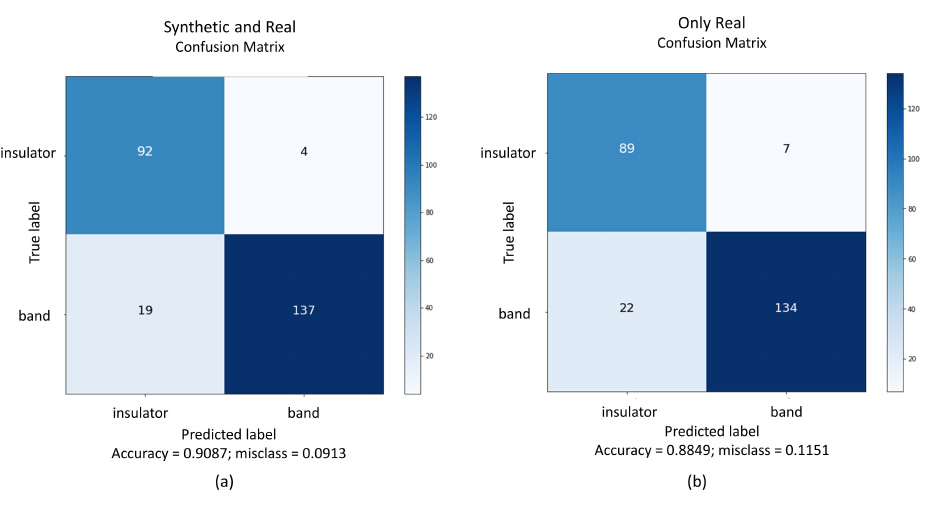
Figure 24. Confusion Matrixes of R-RGBD-1 tested on: ( a ) Resnet trained on synthetic and real datasets and ( b ) Resnet trained on real